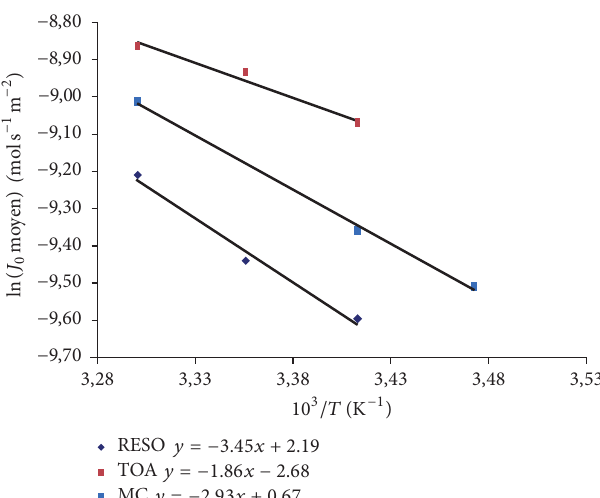
) = 𝑓(1/𝑇) function on the facilitated extraction phenomenon of VO 2+ ions by three membranes: Figure 14: The representation of ln (𝐽 0 moy SLM-RESO (-MC) and